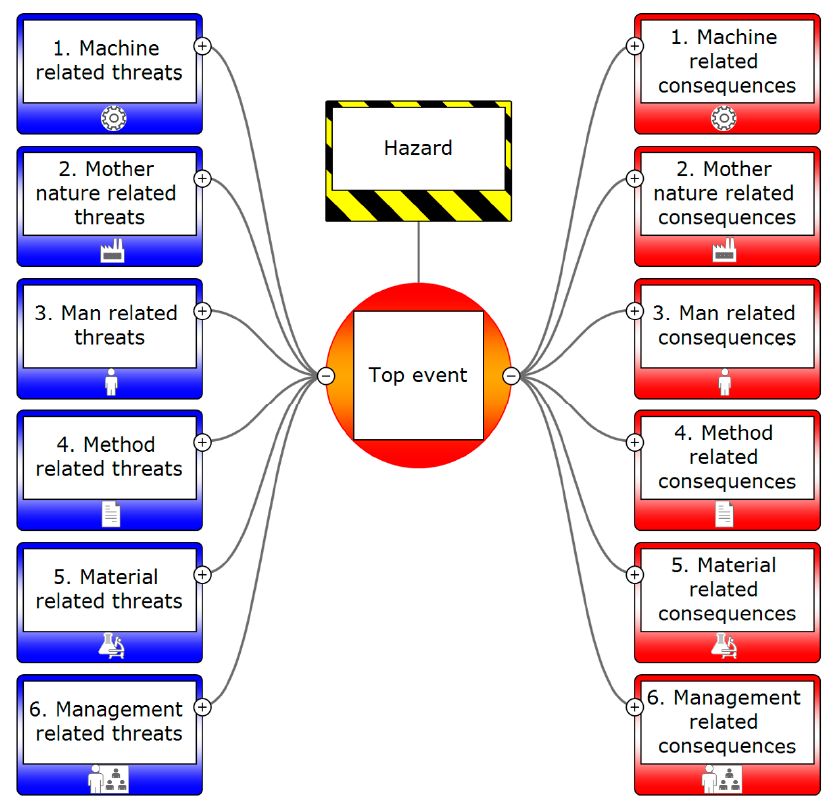
Figure 6. Bowtie with threats and consequences structured based on the 6M approach.